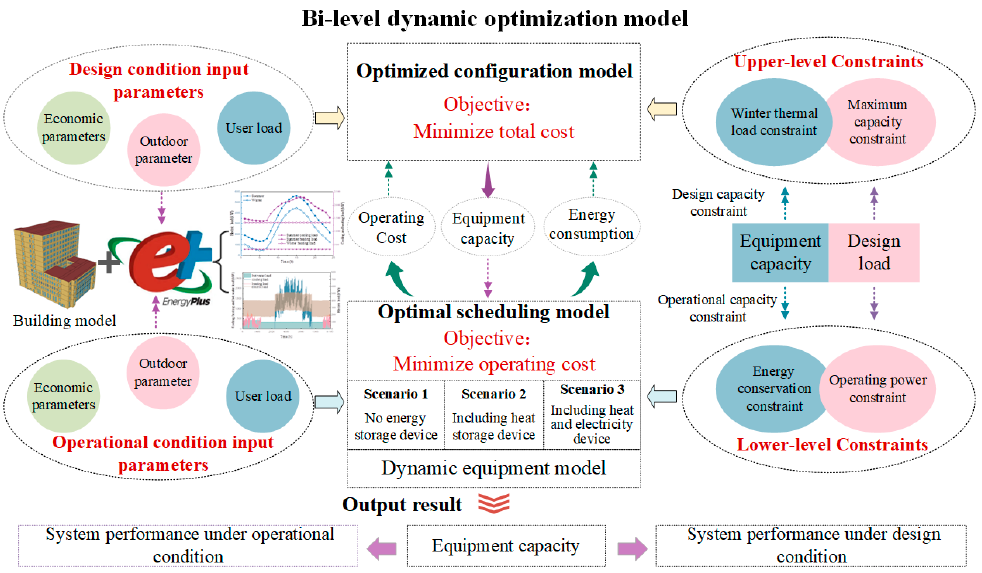
Figure 2. Flow chart of system optimization configuration and operation analysis.